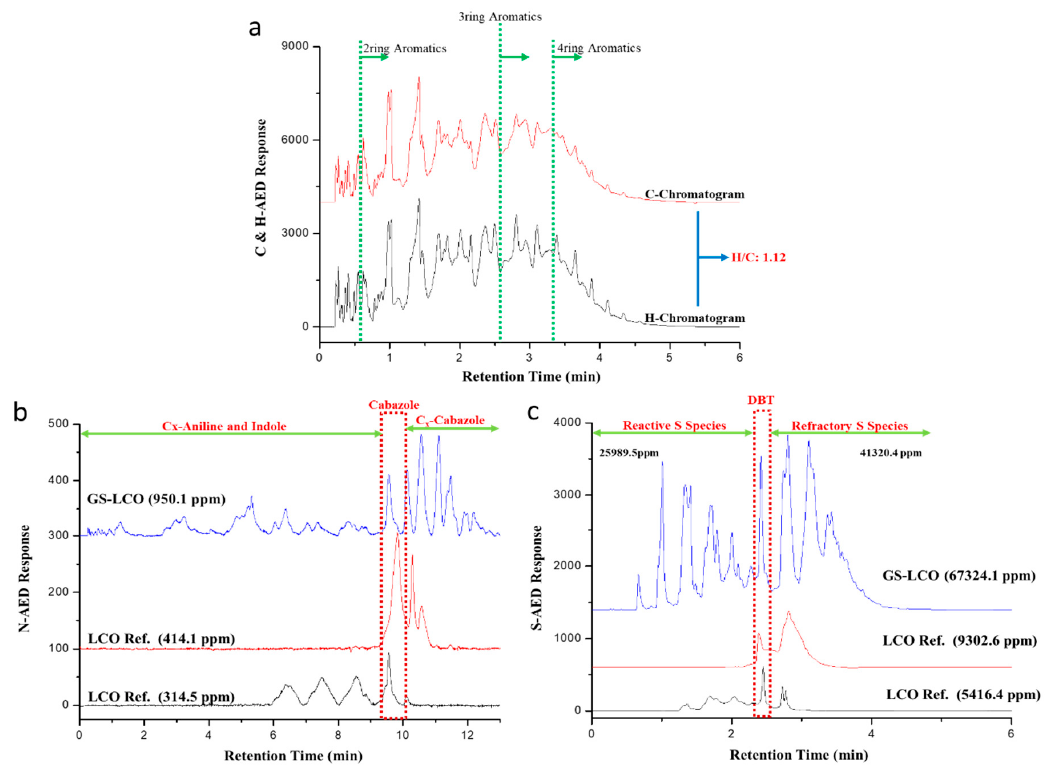
Figure 1. The analytical results of gas chromatography-atomic emission detection (GC-AED) on light cycle oil (LCO) feedstock: ( a ) carbon, ( b ) nitrogen, ( c ) sulfur, with comparisons of LCO references.